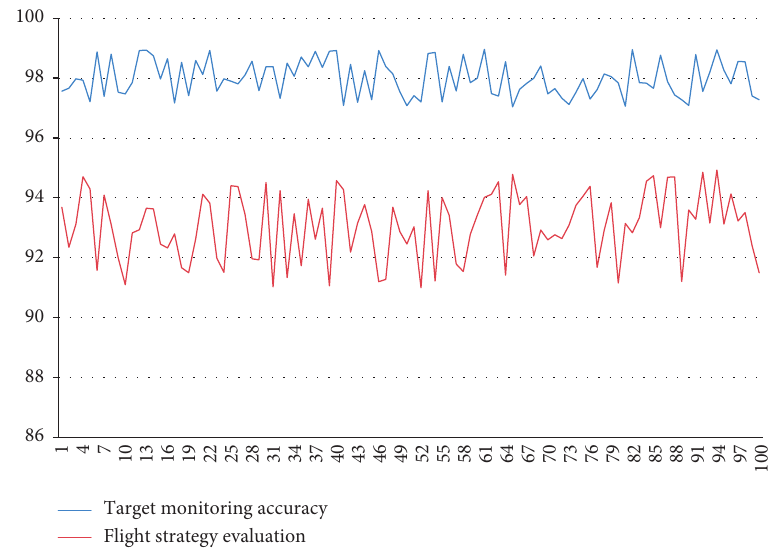
Figure 15: Statistical table of practical effect analysis of the channel optimization system of the ABS-B aviation target surveillance radar based on the improved filtering